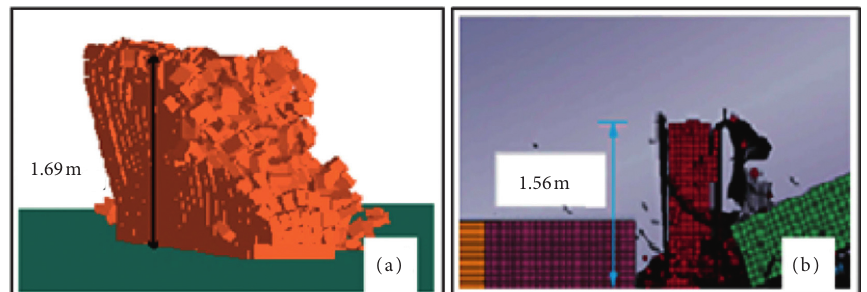
Figure 6: Comparison of the height of the remained part of pier #109 obtained from (a) this study and (b) FEM analysis.